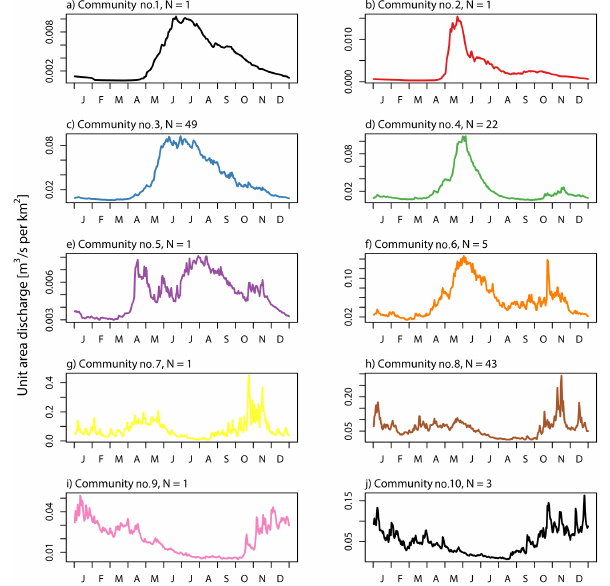
Figure 9. Representative unit area hydrographs for each of the 10 communities. The hydrographs were created by averaging the 10-year median climatology for all stations within the community. The line colours are consistent with the map in Fig. 8, except for the community 10, which is plotted here in black. N gives the number of hydrometric stations within each